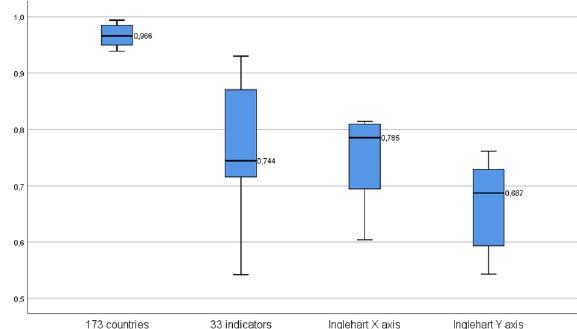
Figure 1. Distribution of correlation coefficients on the CSS